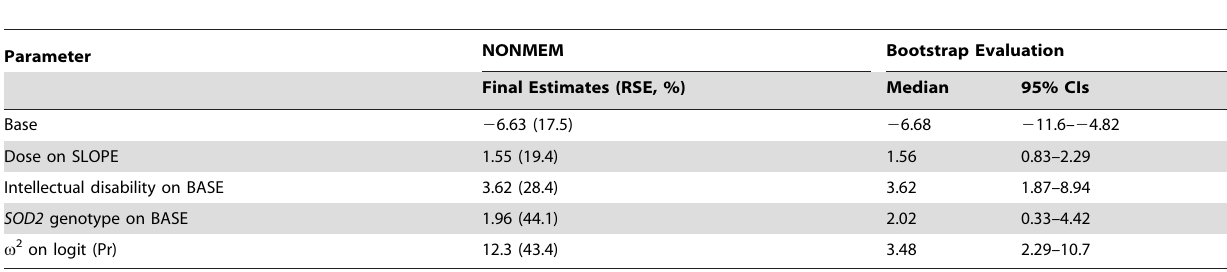
Table 3. The median values of the PD parameter estimates of VPA in the final population PK-PD models obtained using the NONMEM program and the bootstrap